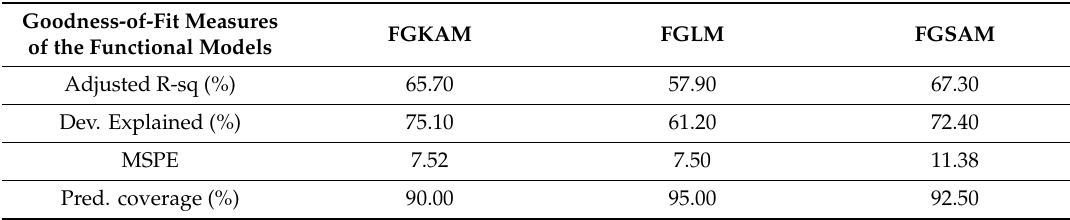
Table 4. Comparison of the predictive abilities of the functional models Functional Generalized Linear Model (FGLM), Functional Generalized Spectral Additive Model (FGSAM), and Functional Generalized Kernel Additive Model (FGKAM) h